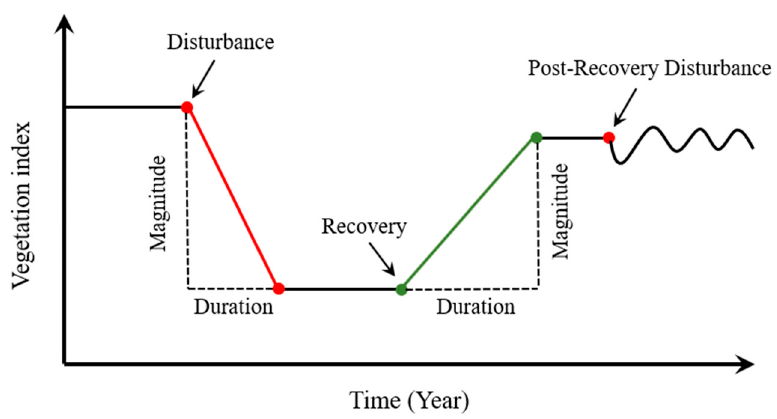
Figure 2. Model for the trajectory of disturbance and recovery in surface mining